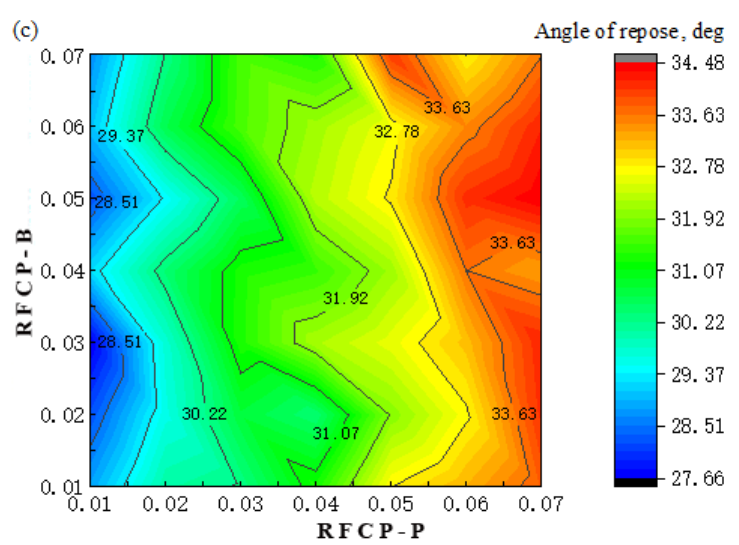
Figure 13. Sensitivity analysis of RFCP-P and RFCP-B to angle of repose for ( a ) SN42, ( b ) JD17, and ( c ) ZD39.